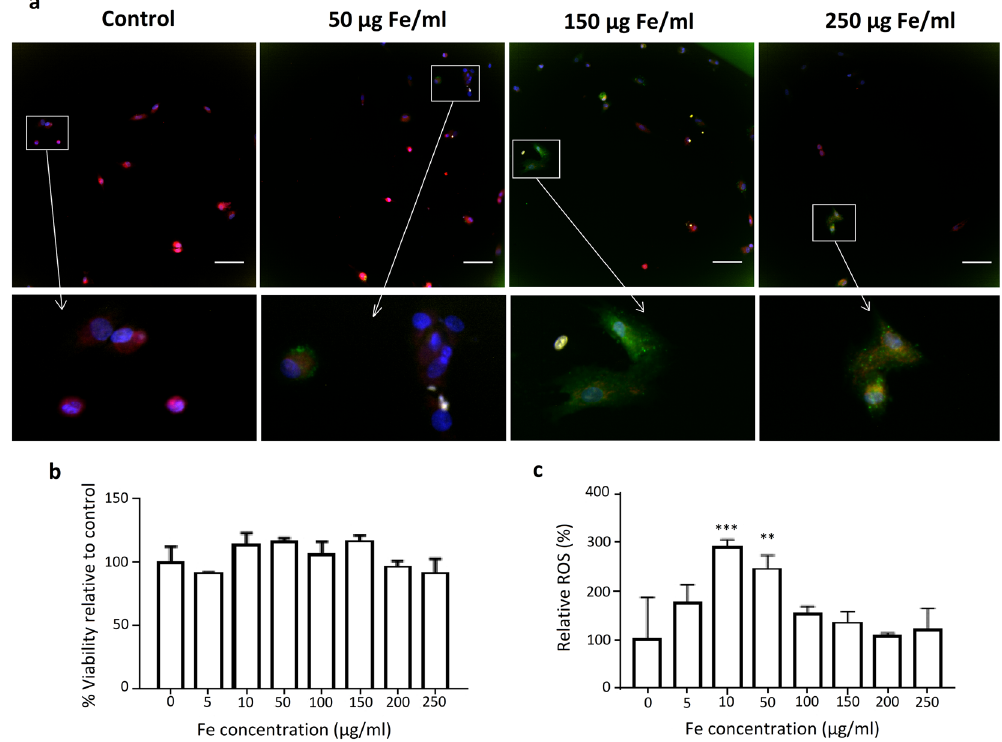
Figure 5. ( a ) Cell viability (yellow), oxidative stress (green) and mitochondrial health (red) of hMSCs labelled with IONPs at various concentrations and determined by high-content imaging reveals significant induction of reactive oxygen species (ROS; green colour) at 10 and 50 µ g Fe/ml. Scale bar 100 µ m. ( b ) Relative viability and ( c ) production of reactive oxygen species determined by high-content imaging. Data are represented relative to untreated control cells as mean ± SD for minimum 500 cells per condition, scale bar 100 µ m. The degree of significance is indicated when appropriate * P < 0.05, ** P < 0.01 and *** P < 0.001 (one-way ANOVA, Dunnett post-hoc test).